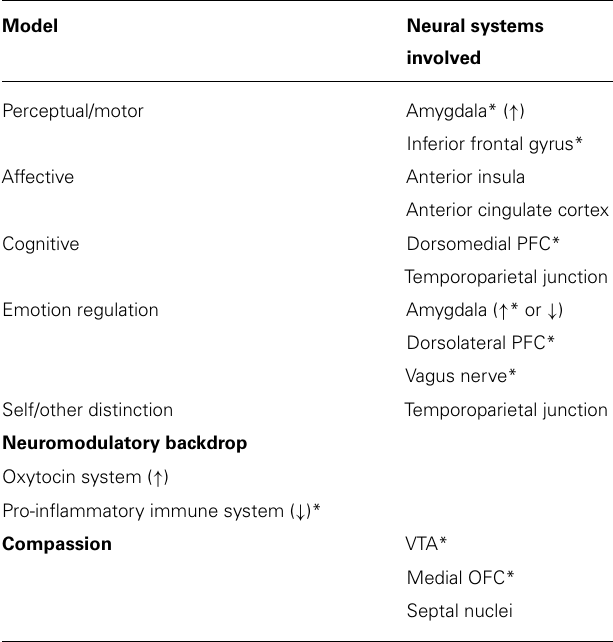
Table 2 | Synopsis of model presented